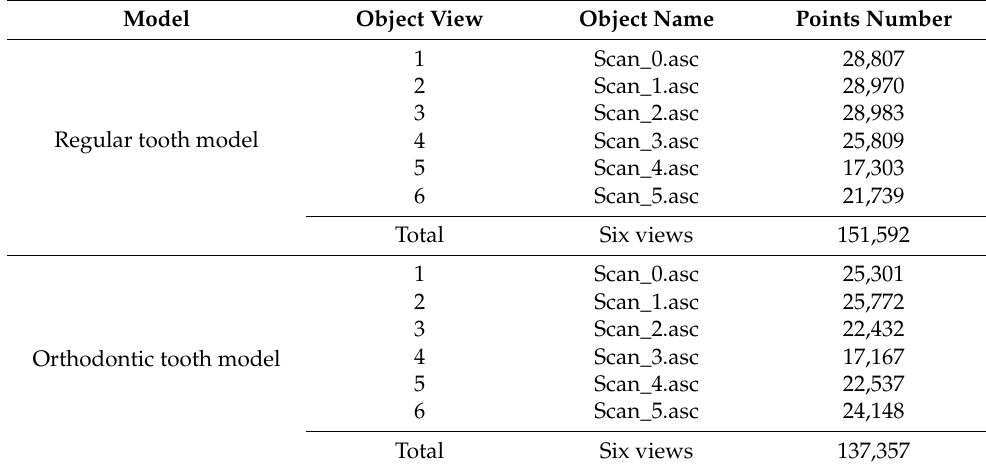
Table 4. Tooth dataset information.